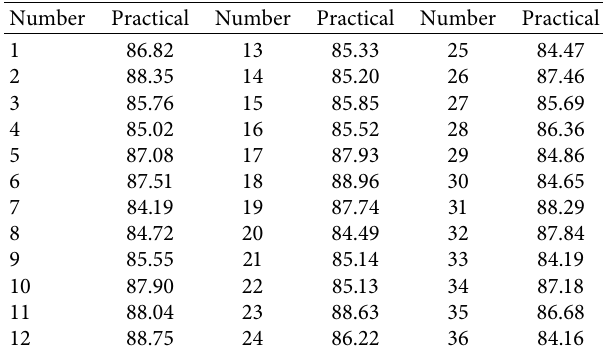
Table 1: Synergistic effect of e-commerce logistics. Synergy